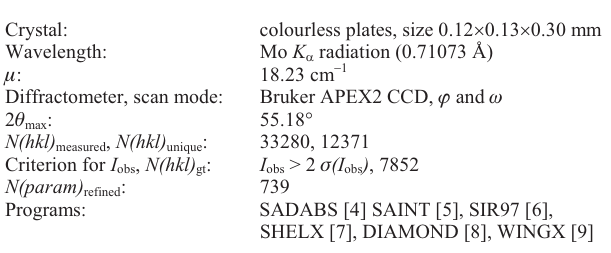
Table 1. Data collection and handling.